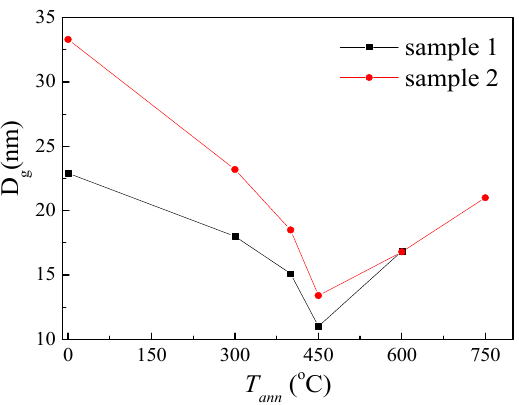
Figure 16. Grain size distribution as a function of the annealing temperature, for Hitperm Fe 38.5 Co 38.5 B 18 Mo 4 Cu 1 microwires. Reproduced from reference [70], Figure 9.